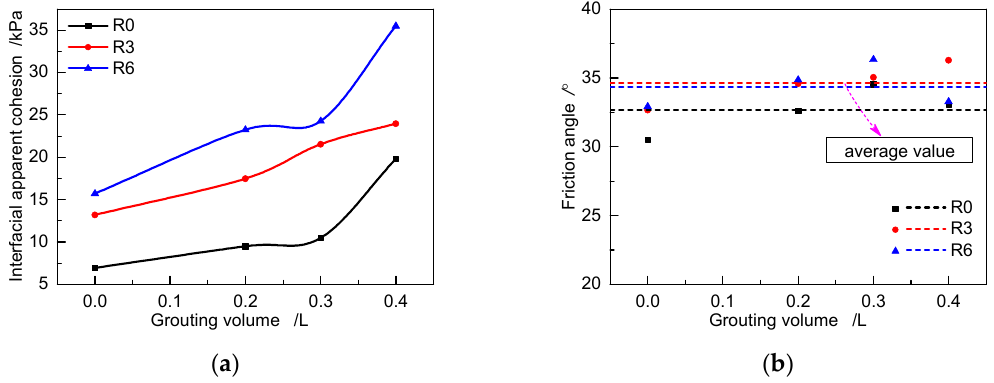
Figure 12. Relationship of interfacial apparent cohesion and friction angle with respect to the grouting volume for specimens with different roughness values under unloading conditions: ( a ) Interfacial apparent cohesion variation with grouting volume; ( b ) Friction angle variation with grouting volume.